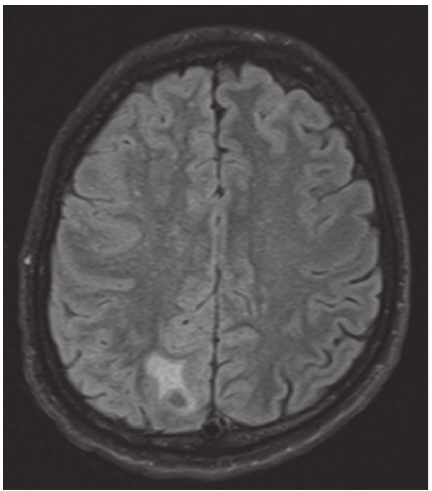
Figure 7: MRI flair image at the same level depicts oedema sur- rounding a small, nodal